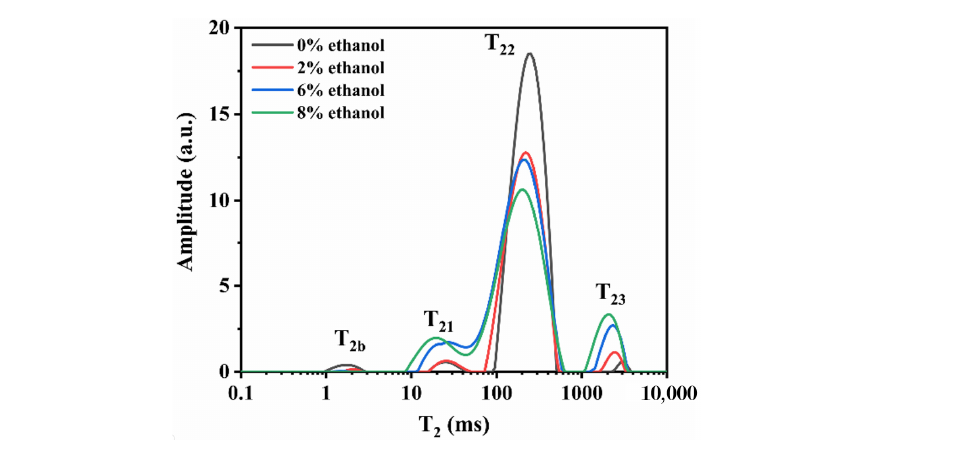
Figure 6. SEM images of konjac emulgel-based fat analogue (KGFA) with different ethanol content before and after freeze-thaw treatment. ( A , E ): 0% ethanol; ( B , F ): 2% ethanol; ( C , G ): 6% ethanol; ( D , H ): 8% ethanol.